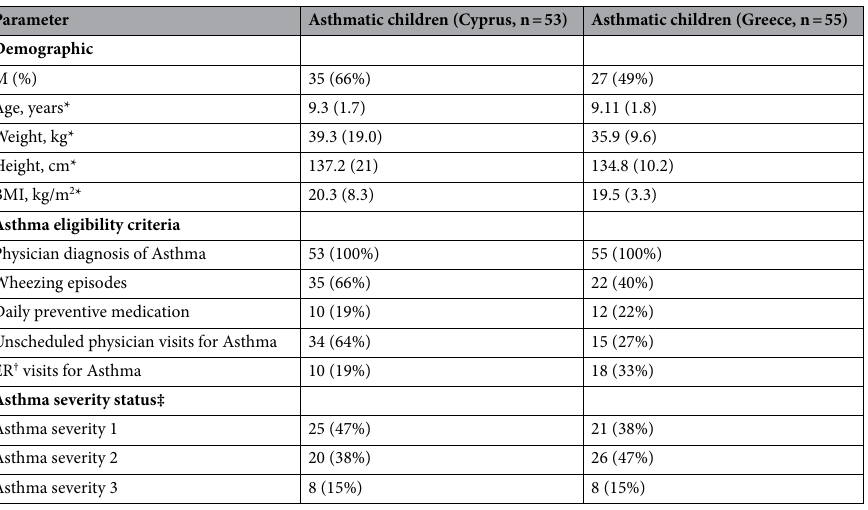
Table 1. Basic demographic and clinical characteristics of asthmatic children in Cyprus and Greece included in the study for the 2020 study period. *Values are presented as Mean (Standard Deviation). † ER: Emergency Department. ‡ Asthma Severity 1: Physician diagnosis plus one other eligibility criterion, Asthma Severity 2: Physician diagnosis plus two other eligibility criteria, Asthma Severity 3: Physician diagnosis plus three or more other eligibility